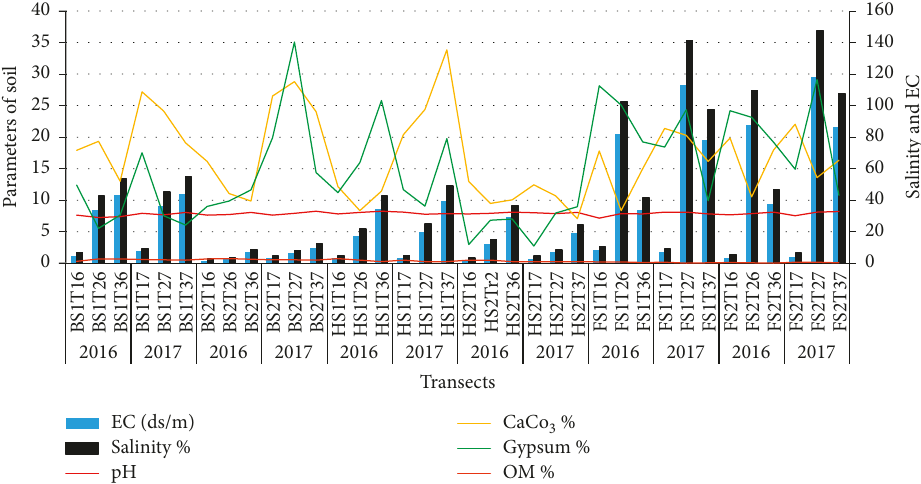
Figure 2: Characteristics of chemical soils according to transects in all sites during study period (2016-2017). (B) Sebkha Bazer, (H) Chott Beida, (F) Chott Frain, (T) Transect (T1, T2, and T3), (S) Station (S1 and S2), year: 2016 (6), year: 2017 (7).